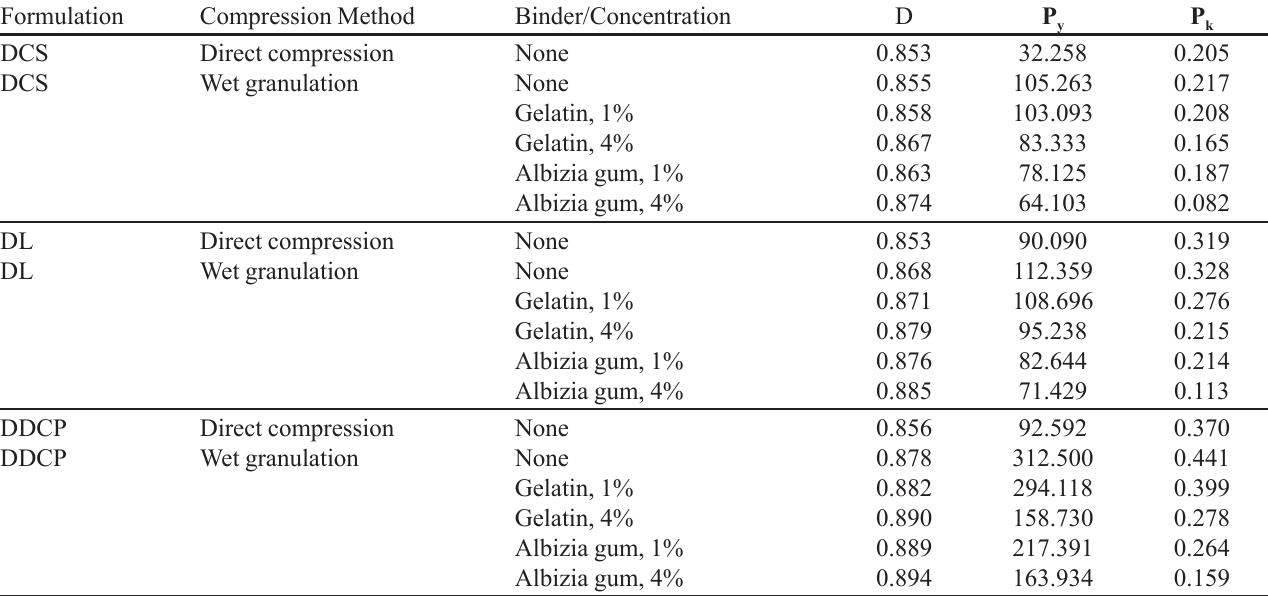
and P for diclofenac formulations y k